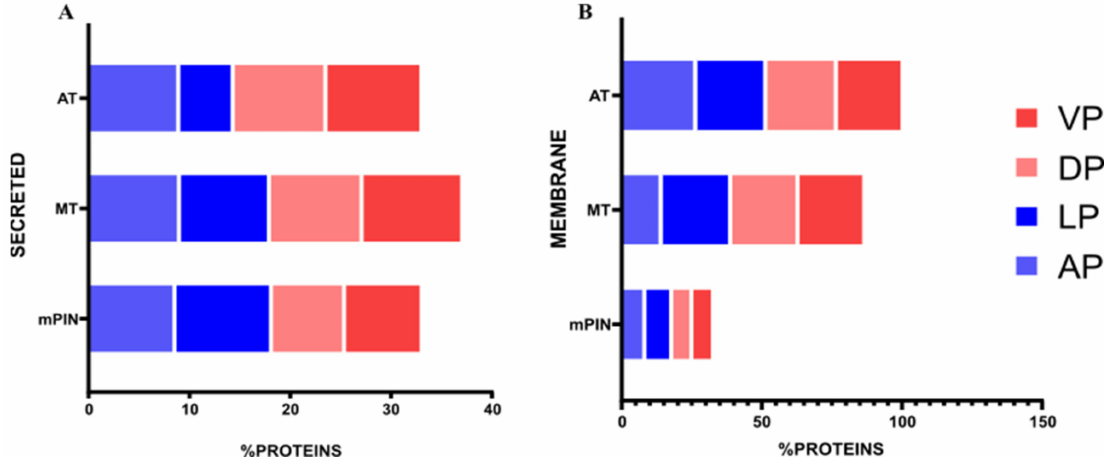
Figure 1. The proportion of membrane and secreted proteins downregulated and upregulated found in transcriptomics data of GEMM Pb-Cre4/Pten f/f PCa. ( A ) Bar plot showing the proportion of membrane protein in GEMM Pb-Cre4/Pten f/f PCa in VP, DP, LP, and AP; ( B ) Bar plot showing the proportion of secreted protein in GEMM Pb-Cre4/Pten f/f PCa in VP, DP, LP, and AP. VP = Ventral prostate; DP = Dorsal prostate; LP = Lateral prostate; AP = Anterior prostate. mPIN = mouse Prostatic Intraepithelial Neoplasia; MT = Middle-stage tumor; AT = Advanced-stage